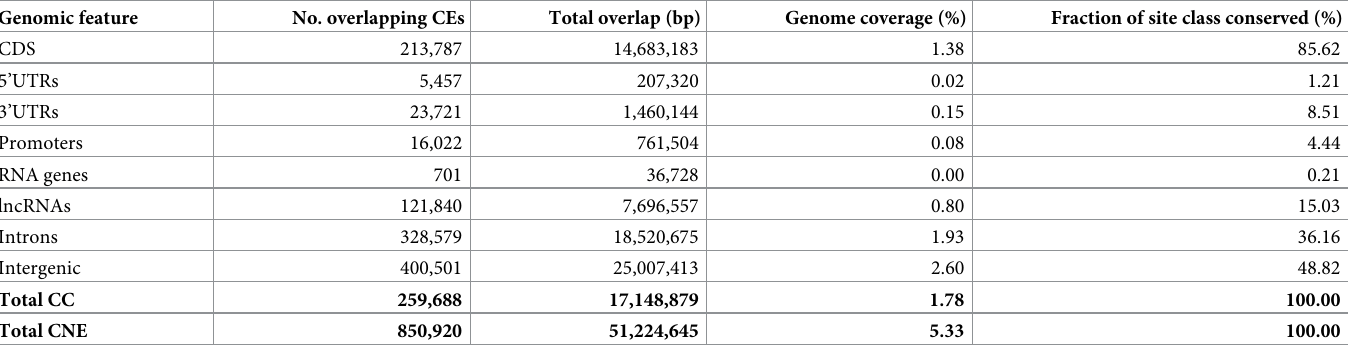
Table 1. Statistics of predicted conserved elements (CEs) based on genomic feature. The fraction of CEs per sites class is presented, for protein-coding gene annotations, in percentages of the exonic CEs (17,148,879 bp). For non-protein-coding gene annotations, the fraction is relative to the non-exonic CEs (51,224,645 bp). Abbreviations: CC, conserved coding; CNE, conserved non-protein-coding